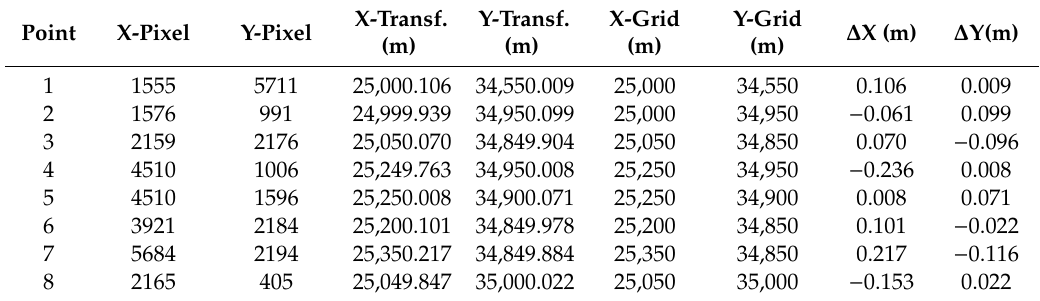
Table 4. Transformed coordinates from pixel coordinates in a ffi ne model, grid coordinates, and di ff erences in between.